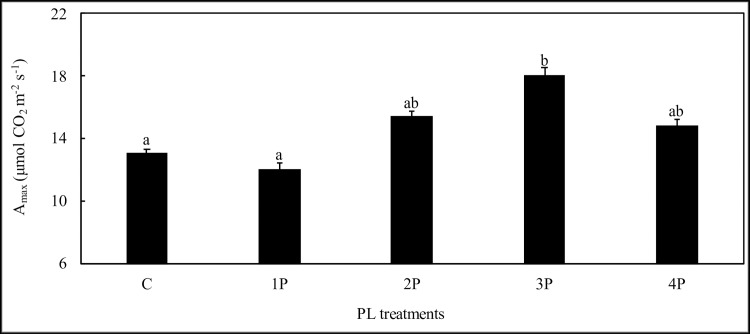
Effects of PL treatments (1P, 2P, 3P and 4P) on leaf maximum net assimilation photosynthesis (Amax) at D10 (Trial one).